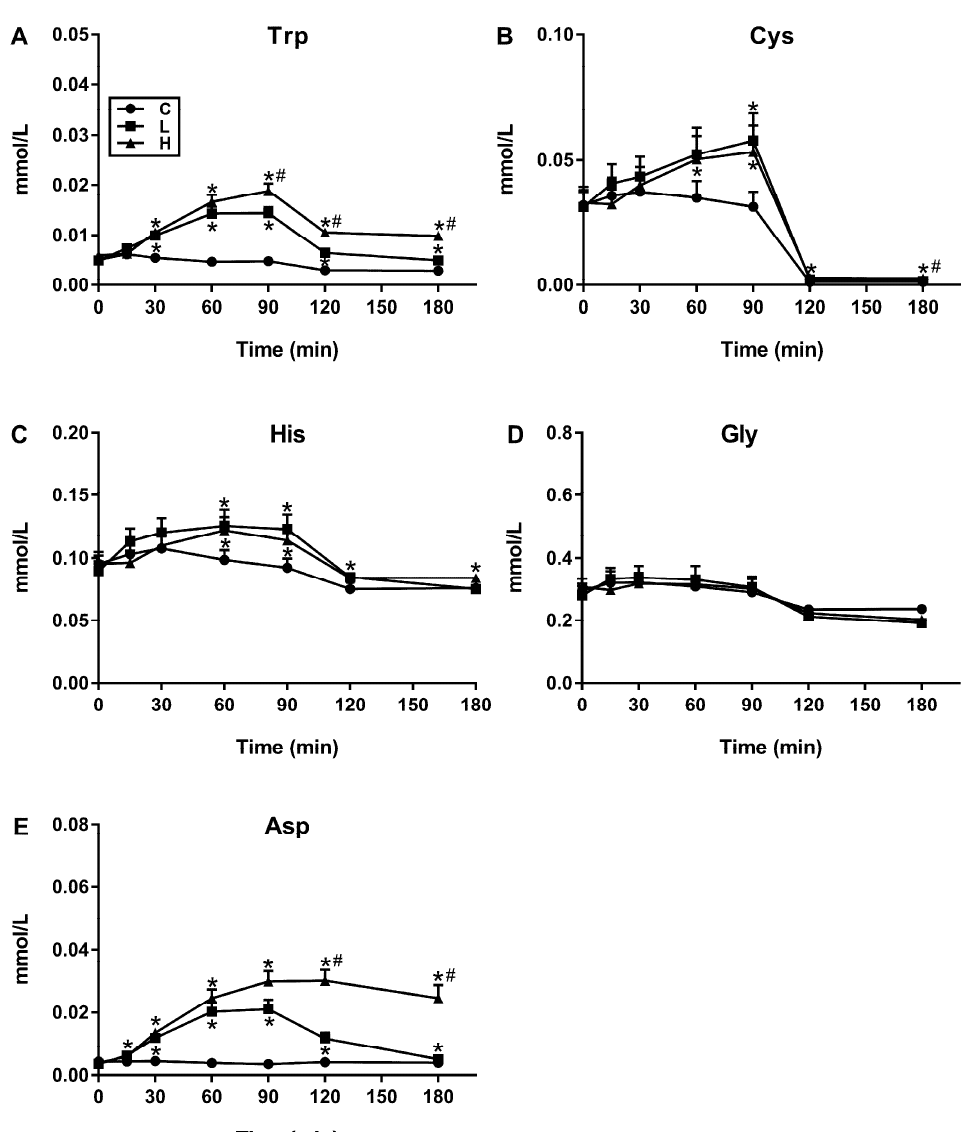
Figure 2. Temporal profiles of ( A ) Tryptophan (Trp), ( B ) Cysteine (Cys), ( C ) Histidine (His), ( D ) Glycine (Gly) and ( E ) Aspartic Acid (Asp), the five amino acids with the weakest response to test drinks containing either 0 g (C), 30 g of whey protein (L) or 70 g of pure whey protein (H) dissolved in varying amounts of distilled water, diet cordial and sodium chloride so they were matched for volume and osmolarity (all 450 mL and 88 mOsm / L). These responses were defined as being the weakest based on the “magnitude of increase” in each plasma concentration over the 180-min period following the L and H drink, respectively, and relative to C. Data are means ± SEMs, n = 16. E ff ects of protein load and time on individual AAs were determined by a two-way ANOVA, and post-hoc comparisons between two loads were determined using Bonferroni’s correction; statistical significance was accepted at p <